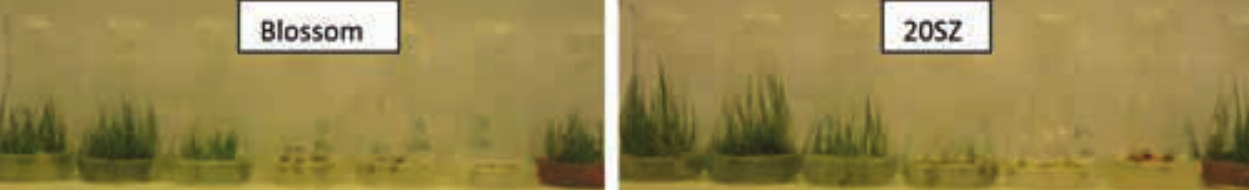
Fig. 3: In vitro Blossom and 20SZ Arundo donax L. ecotypes treated with 0; 1; 10; 20; 50; 100 mg L -1 sodium-selenate or red elemental nanoselenium suspension (100 mg L -1